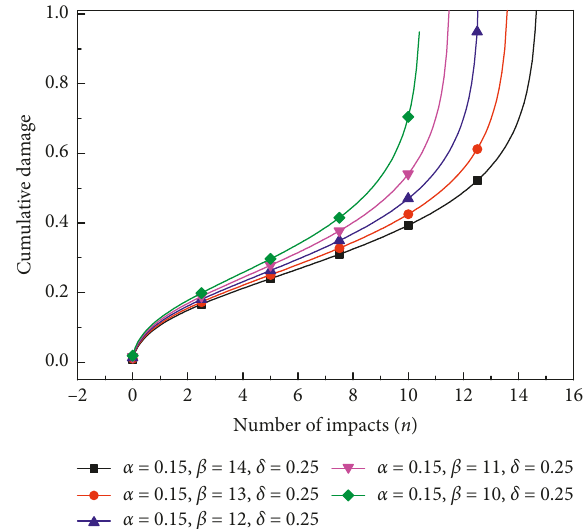
Figure 10: Influence of β to the model